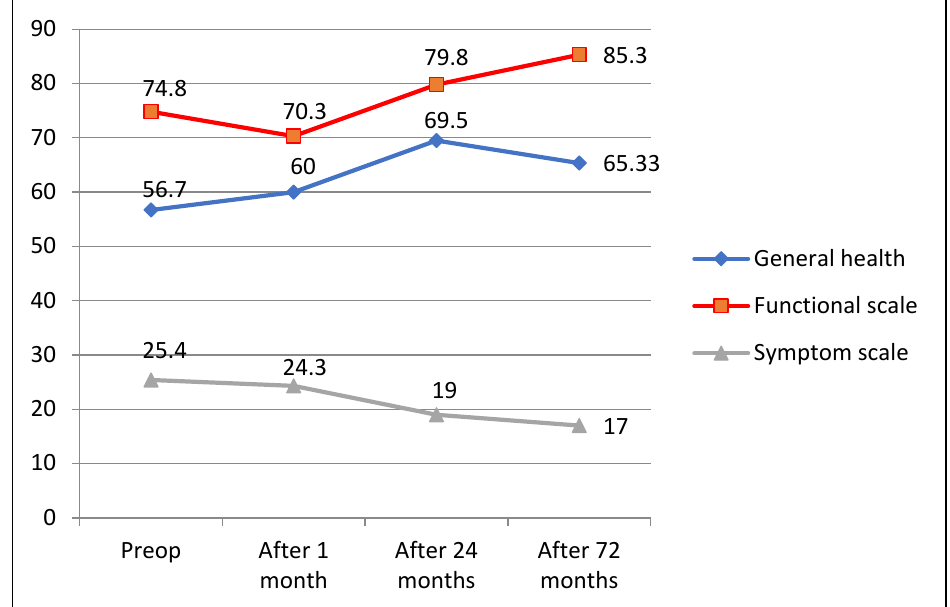
Figure 4. QLQ-C30 questionnaire outcomes 72 months after surgery.